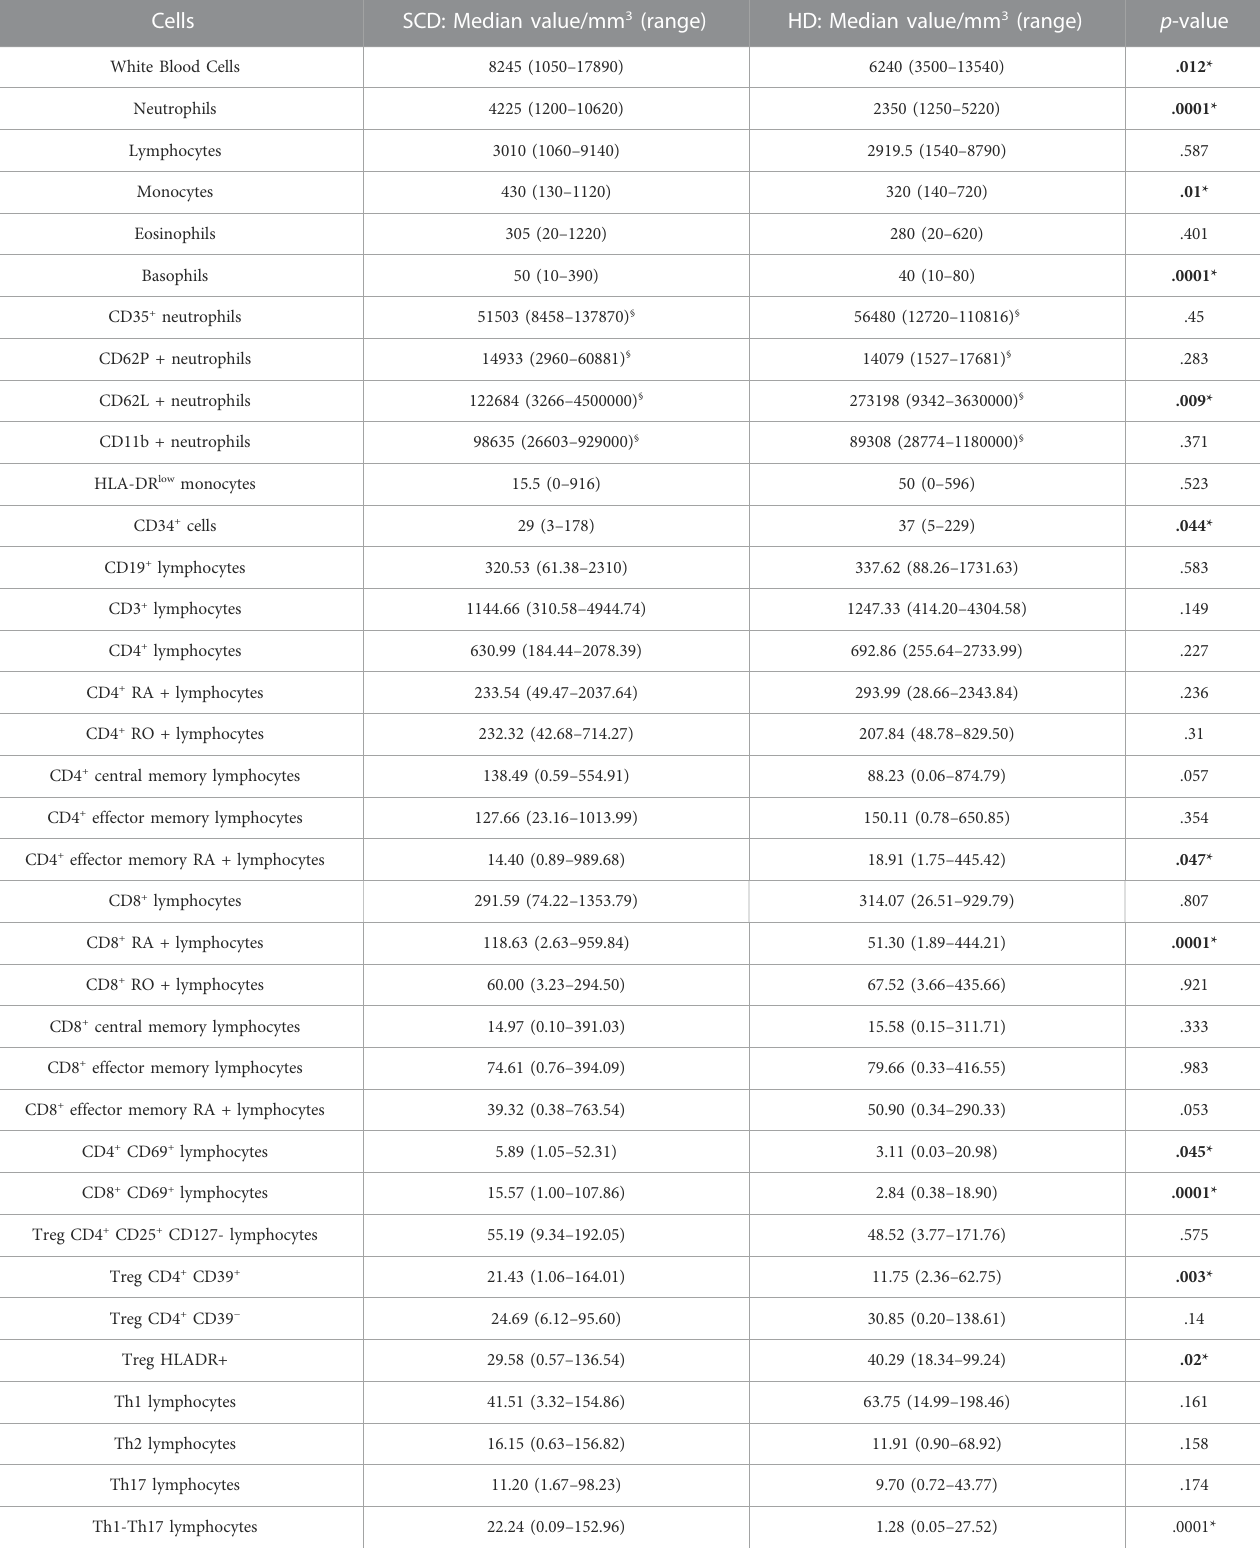
TABLE 3 Main differences in the immunological pro fi le (in absolute number) between Sickle Cell Disease population and Healthy Donors. *Data with statistical signi fi cance. §Data expressed in MFI (Mean Fluorescence Intensity).